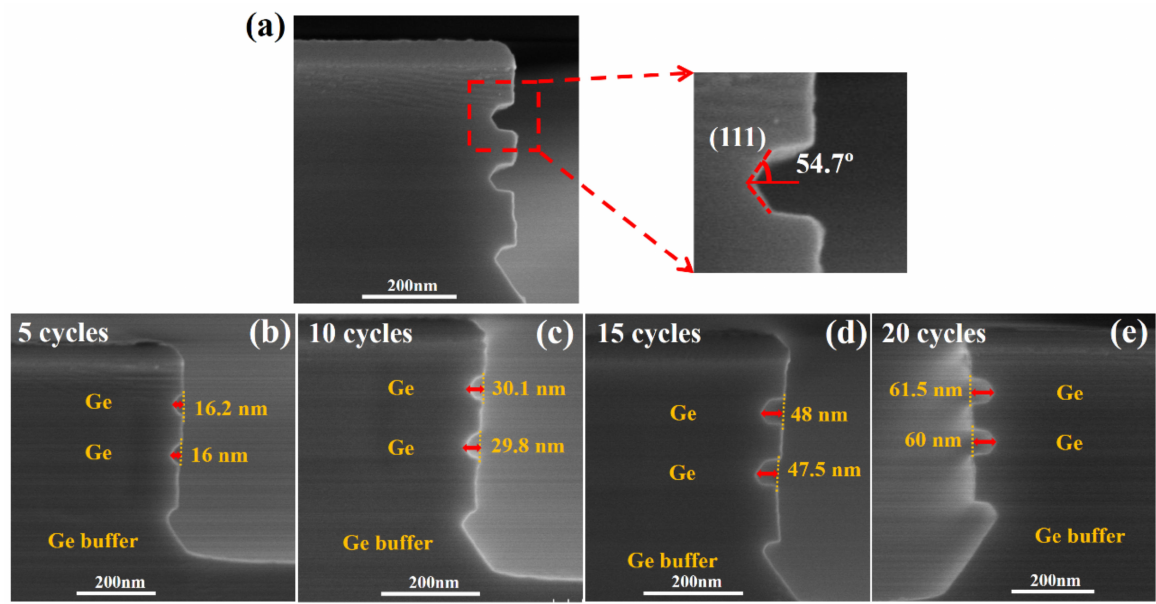
Figure 3. ( a ) The dual-selective etch of Ge at (111) planes result in a lateral angle of 54.7 ◦ . The SEM cross-section images of p + -Ge 0.8 Si 0.2 /Ge multilayers after 70% HNO 3 -DI water ALE at ( b ) 5 cycles, ( c ) 10 cycles, ( d ) 15 cycles, and ( e ) 20 cycles. (Oxidation time t ox = 30 s; temperature of HNO 3 = 20 ◦